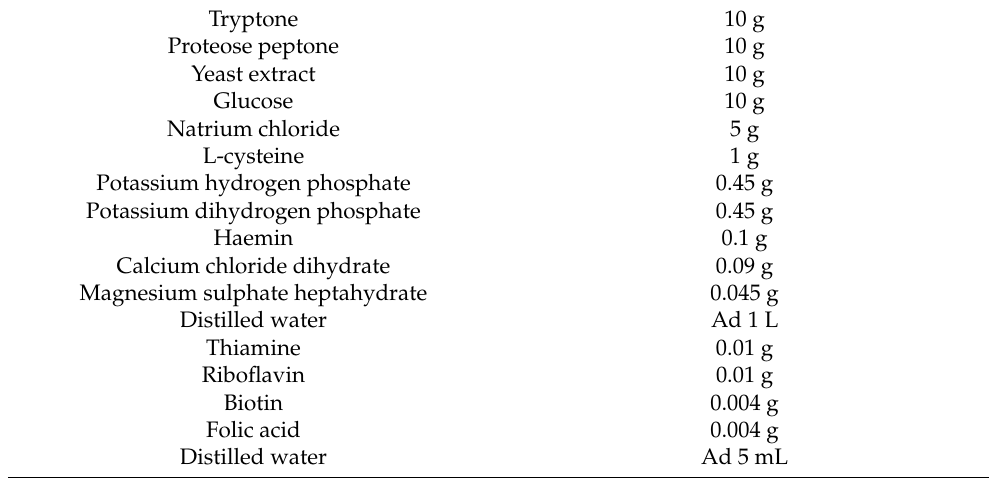
Table 6. Composition of the home-made supplement mix we added to all of the the pre-incubation bottles. The composition is based on the YCFA and R-medium previously used by Didier Raoult et al. [14]. The first 12 ingredients are sterilized through an autoclave. The other four ingredients are thermolabile and were sterilized through filtration. Sterility was checked at the end of the